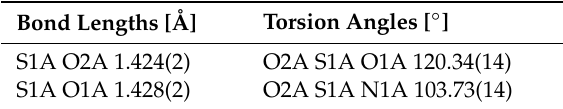
Table A1. Bond lengths and torsion angles in 1